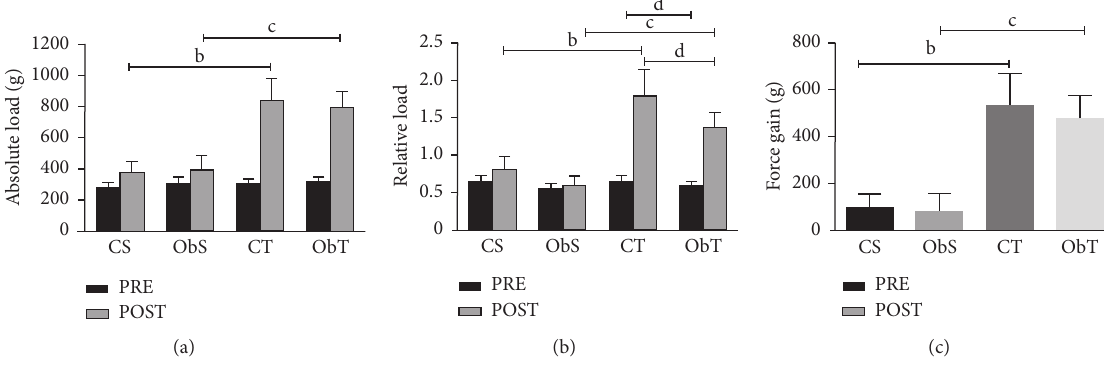
Figure 4: Data expressed as mean ± standard deviation. CS � sedentary control ( n � 10); CT � control submitted to the strength training protocol ( n � 10); ObS � sedentary obese ( n � 7); ObT � obese submitted to strength training protocol ( n � 9). p < 0 . 05: b CT vs. CS; c ObT vs. ObS; d ObT vs. CT. Two-way ANOVA supplemented with the Bonferroni post hoc test for normal distribution data.